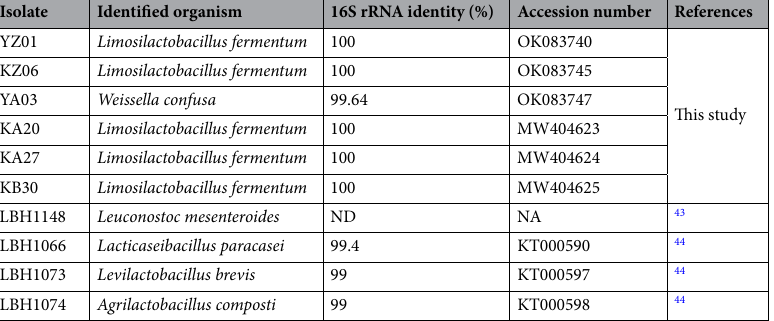
Table 1. Identity of the selected lactic acid bacteria producing α-Gal. NB: Percentage similarity of ≥ 97% to existing 16S rRNA genes in NCBI database was used for organism identification with a minimum of 750 bp